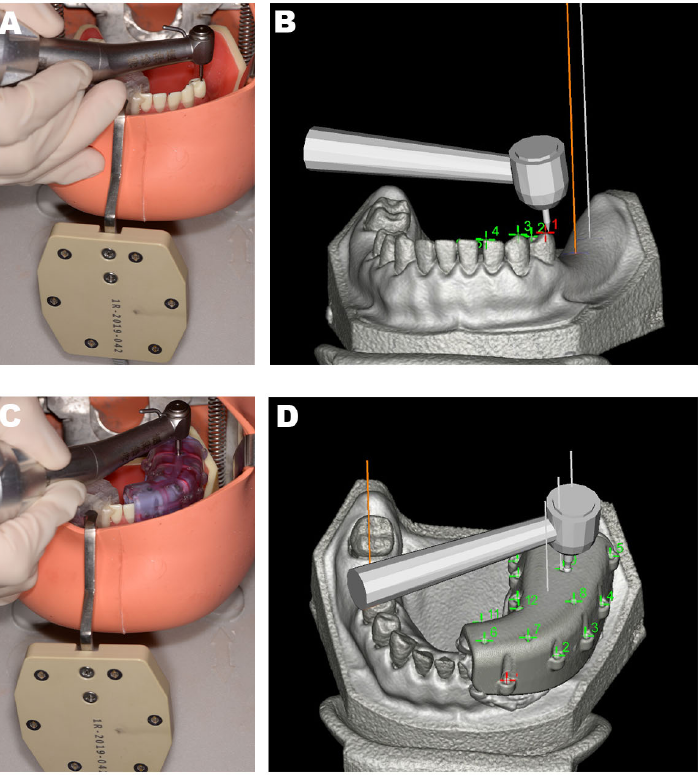
Figure 4. The process of registration. ( A ) cusp registration in oral; ( B ) cusp registration in software; ( C ) U-tube registration in oral; ( D ) U-tube registration in software. The red and green points in Figure ( B , D ) are all the points that can be registered. Red one is the point that the mouse clicks in the software.